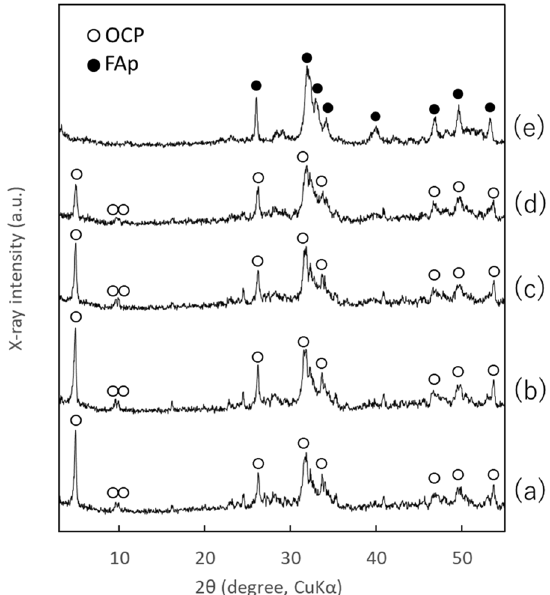
Fig. 1 XRD patterns of calcium phosphates with and without F – ion added during any protamine adsoprtion: a OCP, b OCP-P, c OCP- F10P, d OCP-F100P, and e OCP-F500P